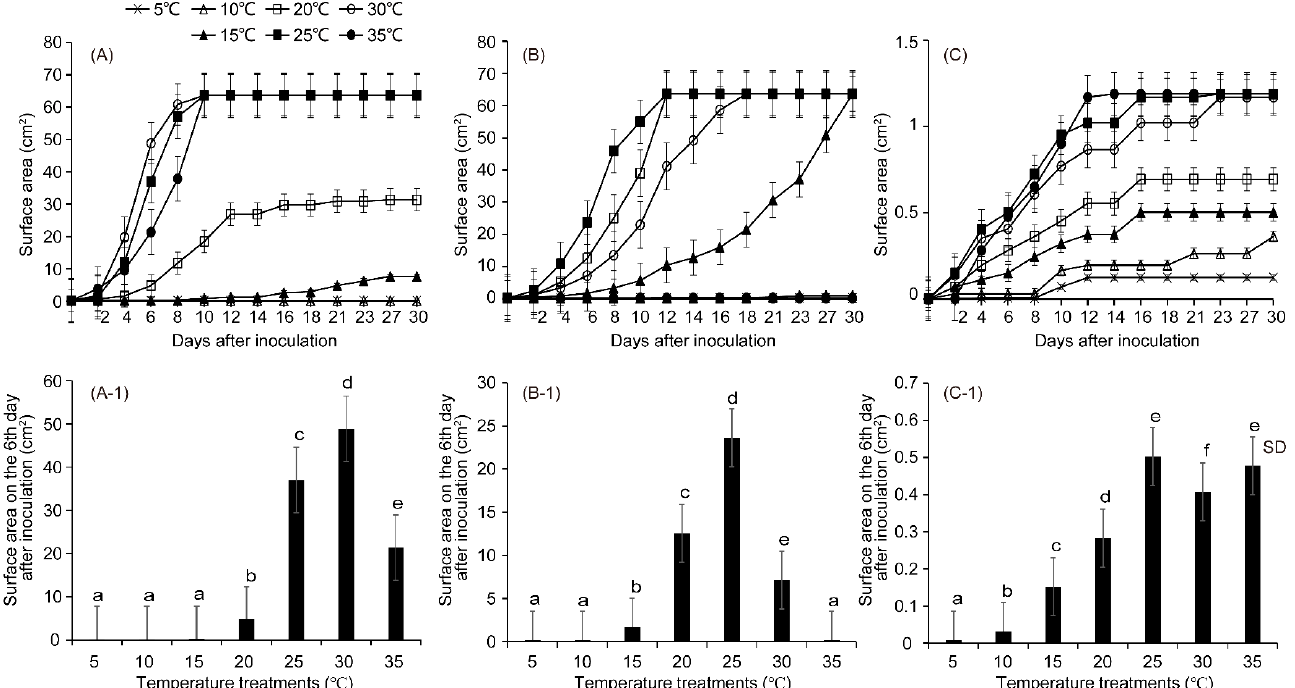
Figure 4. Growth of mycelial cultures of ( A ) Neocosmospora metavorans , ( B ) Fusarium sp., and ( C ) Meyerozyma guilliermondii on the PDA at different temperature treatments (5, 10, 15, 20, 25, 30, and 35 °C). ( A-1 , B-1 , C-1 ) are the fungal colony’s surface area of N. metavorans , Fusarium sp., and M. guilliermondii on the 6th day after inoculation in each temperature treatment, respectively. The overall difference in medians among the temperature treatments (the 6th day after inoculation) is significant at p < 0.001 using Kruskal–Wallis test. Means with different letters (a, b, c, d, e, and f) are significantly different among temperatures at the 1% level. SD, standard deviation. N = 5 replicates per fungal species.